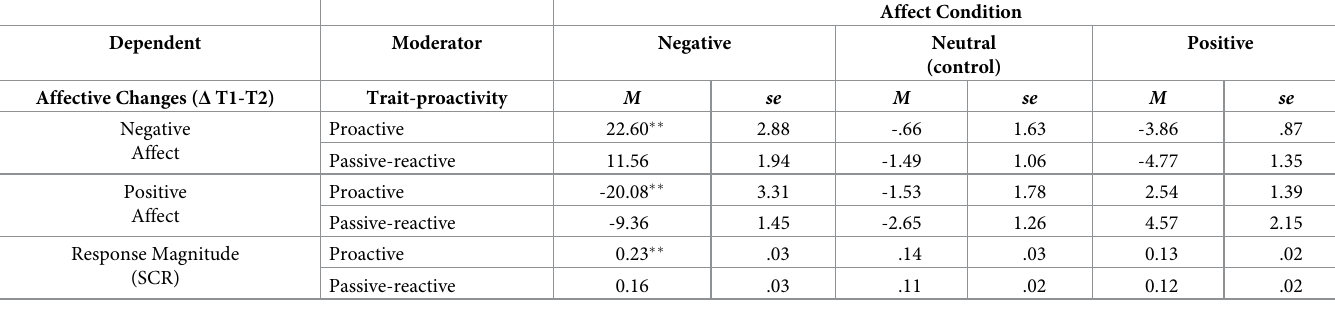
Table 4. Interaction effects of affect condition � trait-proactivity on changes in affect from baseline to after the manipulation ( Δ T1